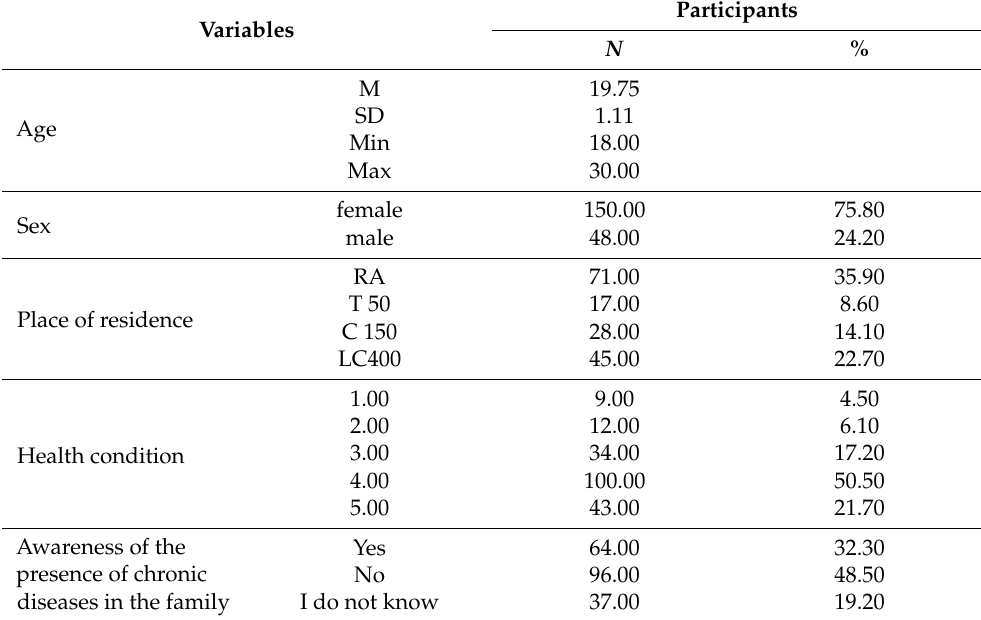
Table 1. Descriptive statistics of socio-demographic variables.